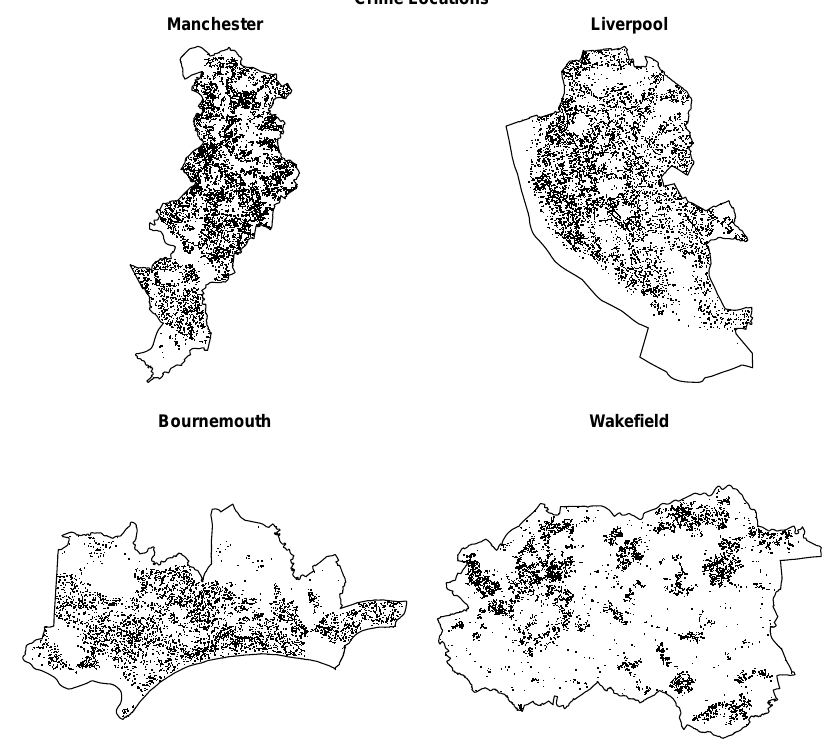
Figure 2. Crime locations within each urban